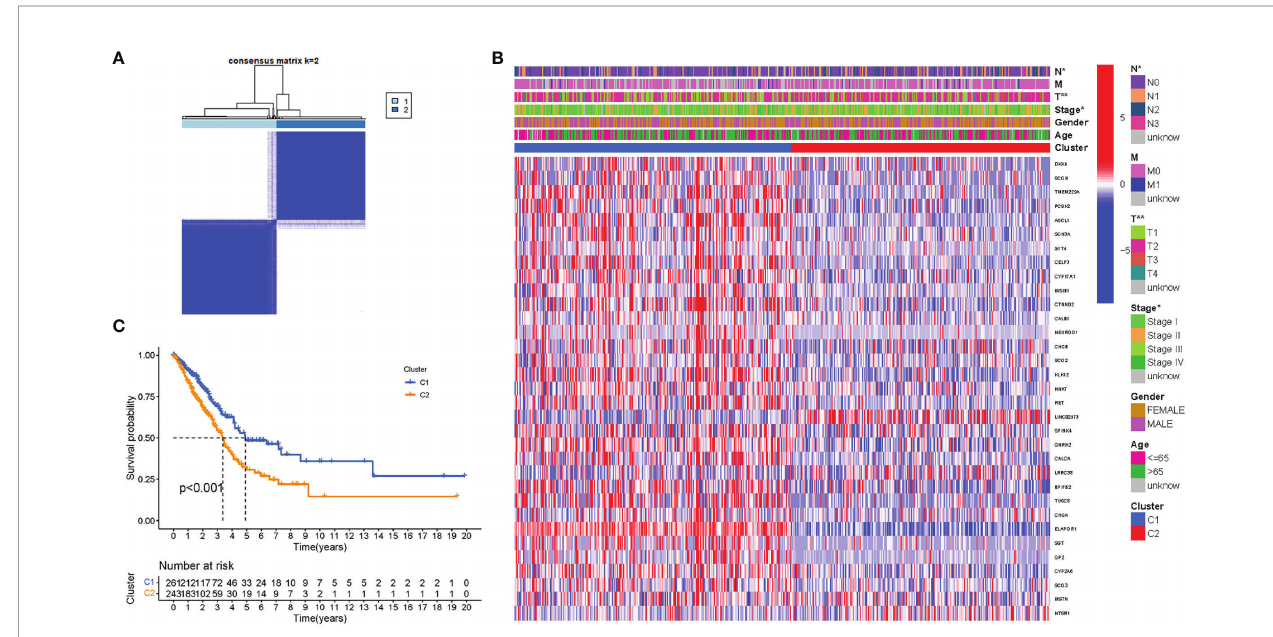
FIGURE 4 | Tumor classi fi cation based on the participating in autophagy DEGs. (A) Here, 535 LUAD patients were grouped into two clusters according to the consensus clustering matrix (k = 2). (B) Heatmap. Heatmap and the clinicopathologic characters of the two clusters classi fi ed by these DEGs (T, N, and Stage are the degree of tumor differentiation. (C) Kaplan – Meier OS curves for the two